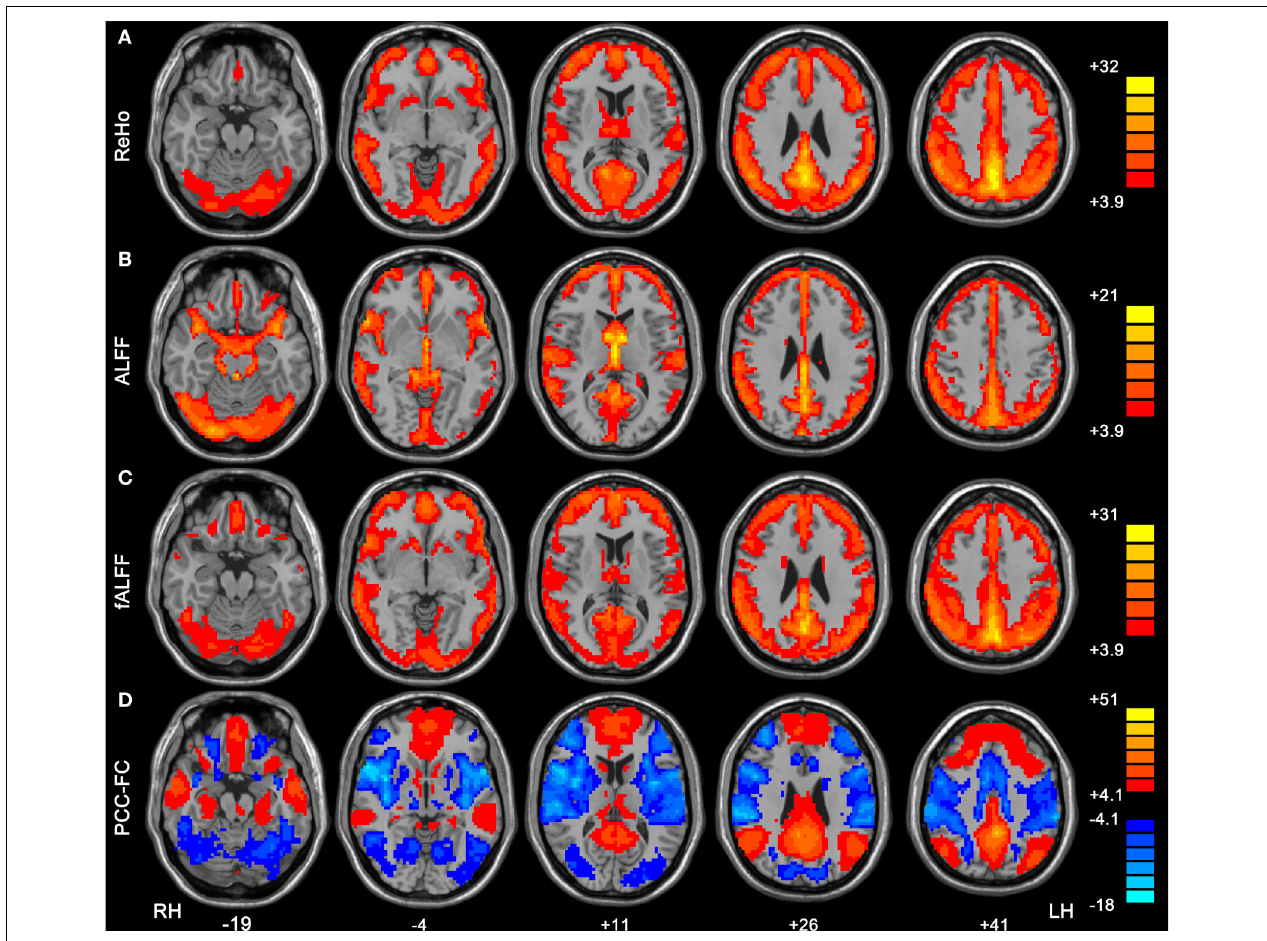
FIGURE 3 | Within-condition patterns of ReHo (A), ALFF (B), fALFF (C) and PCC-FC (D). All these methods revealed the pattern of the default mode network. The numbers below the images refer to the MNI z coordinates. The statistical threshold was set at t > 3.89 ( P < 0.0001) for